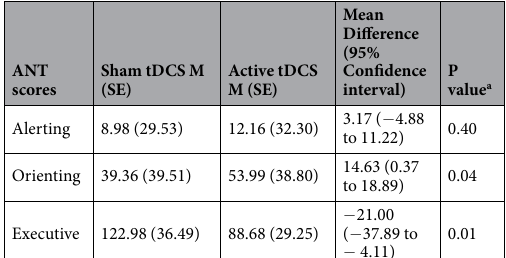
Table 2. Reaction Times (RTs) For Each Stimulation Group According to Target Type and Cue Type (n = 35). Notes: M = mean; SE = standard error. a Main effects based on mixed linear model analyses.